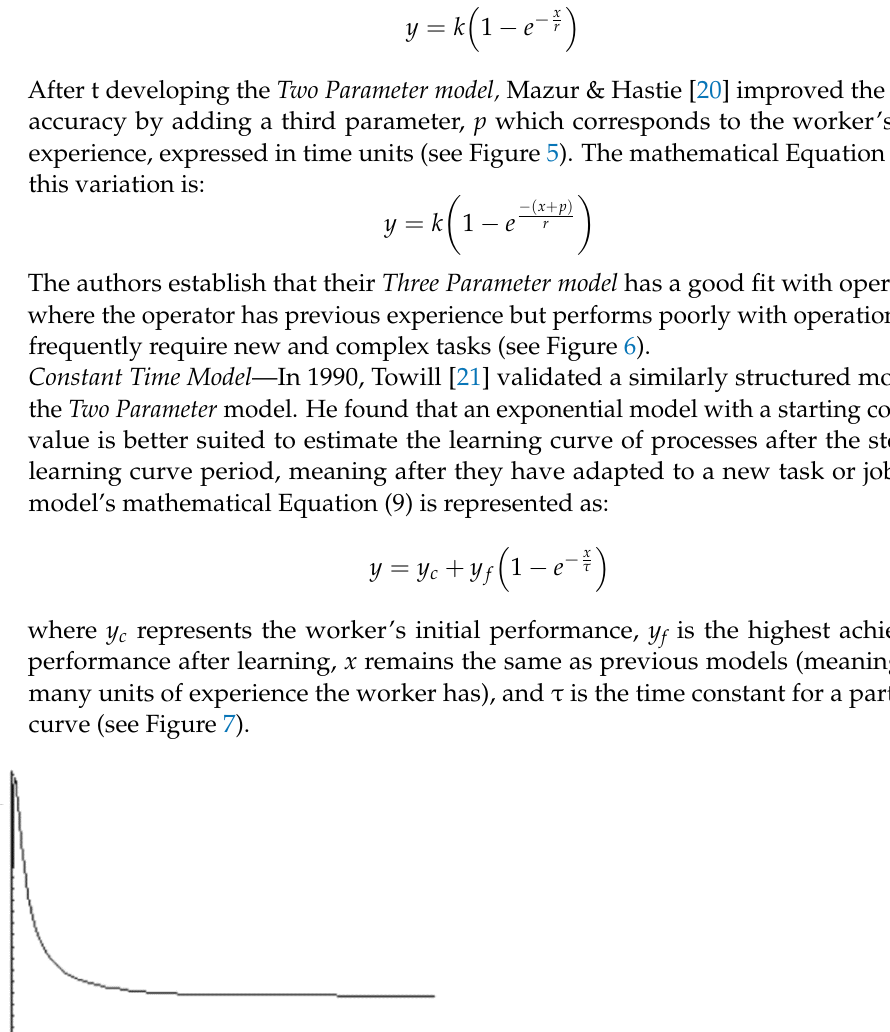
Figure 4. Levy’s adapted function model profile graph [18].